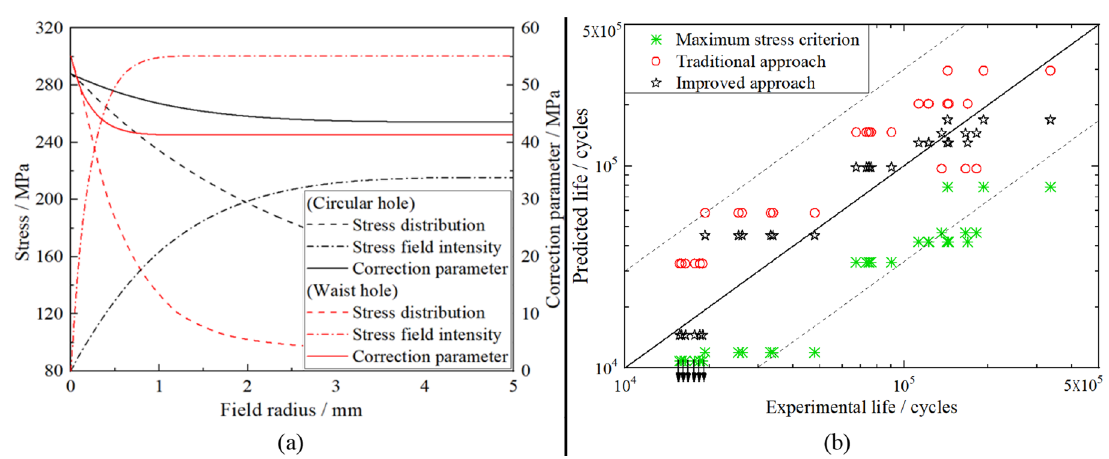
Figure 14. Analysis of fatigue problems for the notch in conventional size: ( a ) Stress field analysis for different holes by the revised approach; ( b ) Accuracy comparison of the three approaches for different notched